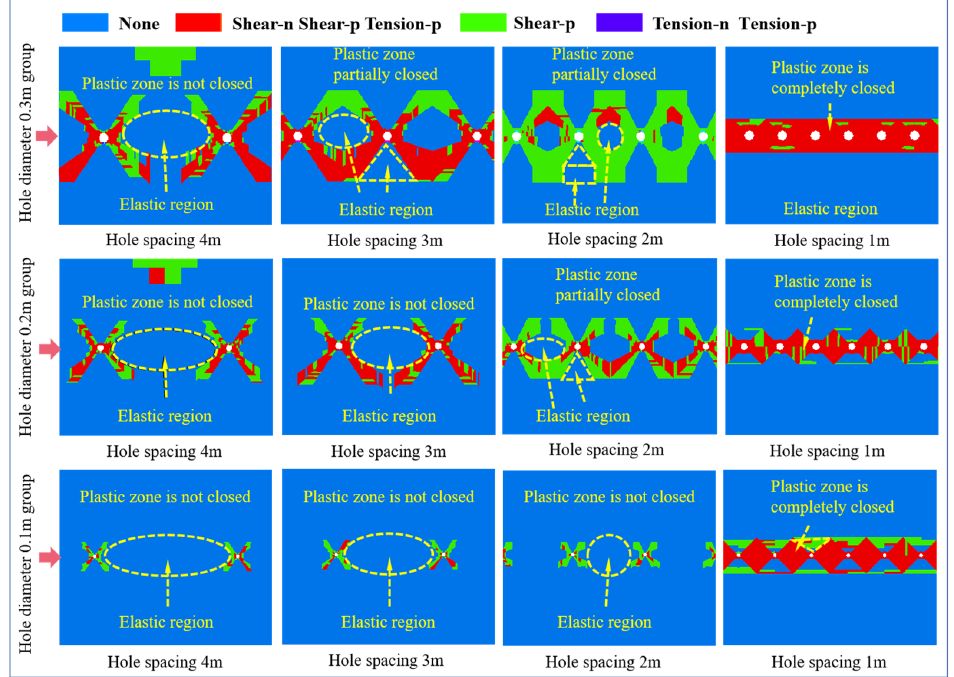
Figure 12. Plastic zone evolution between the boreholes with different hole diameters and hole spac- ings.